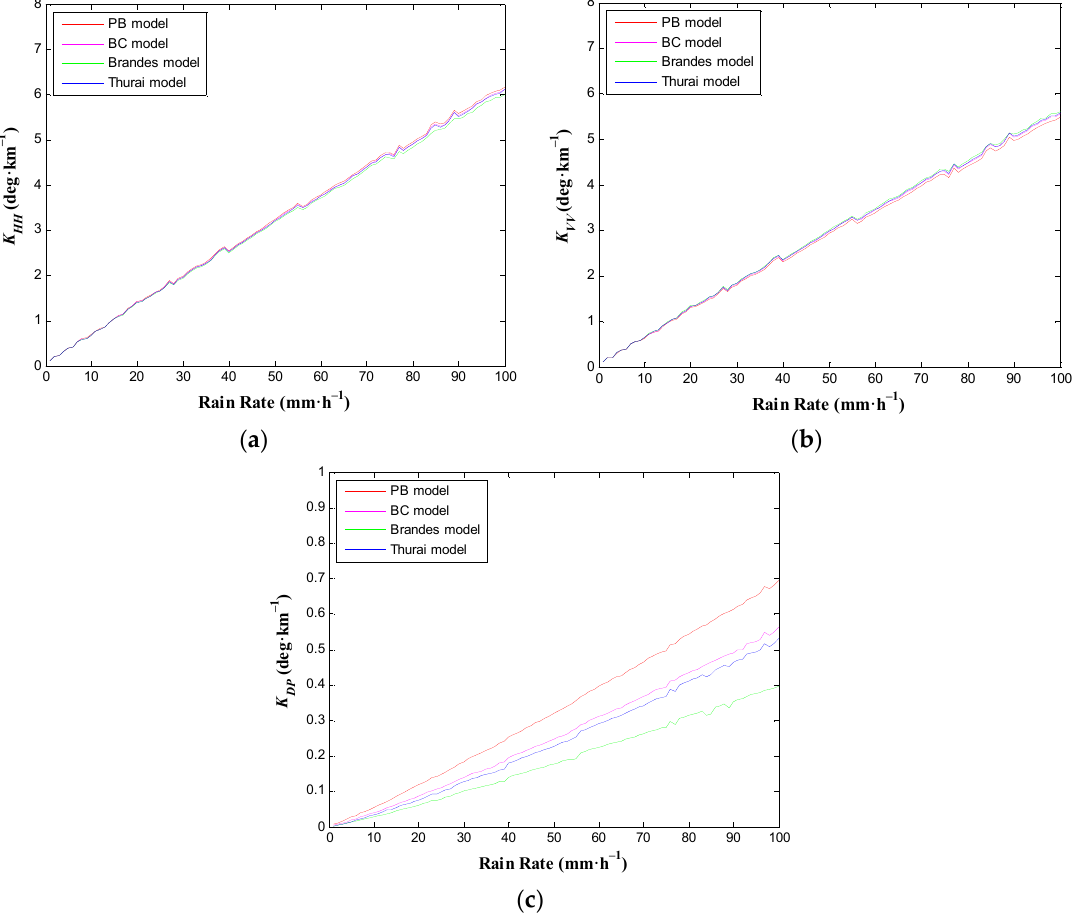
Figure 2. Polarimetric propagation parameters vs. rain rate for various shapes of raindrops at the L1 (1575.42 MHz) frequency of GPS signals. ( a ) K HH - R ; ( b ) K VV - R ; ( c ) K DP - R .